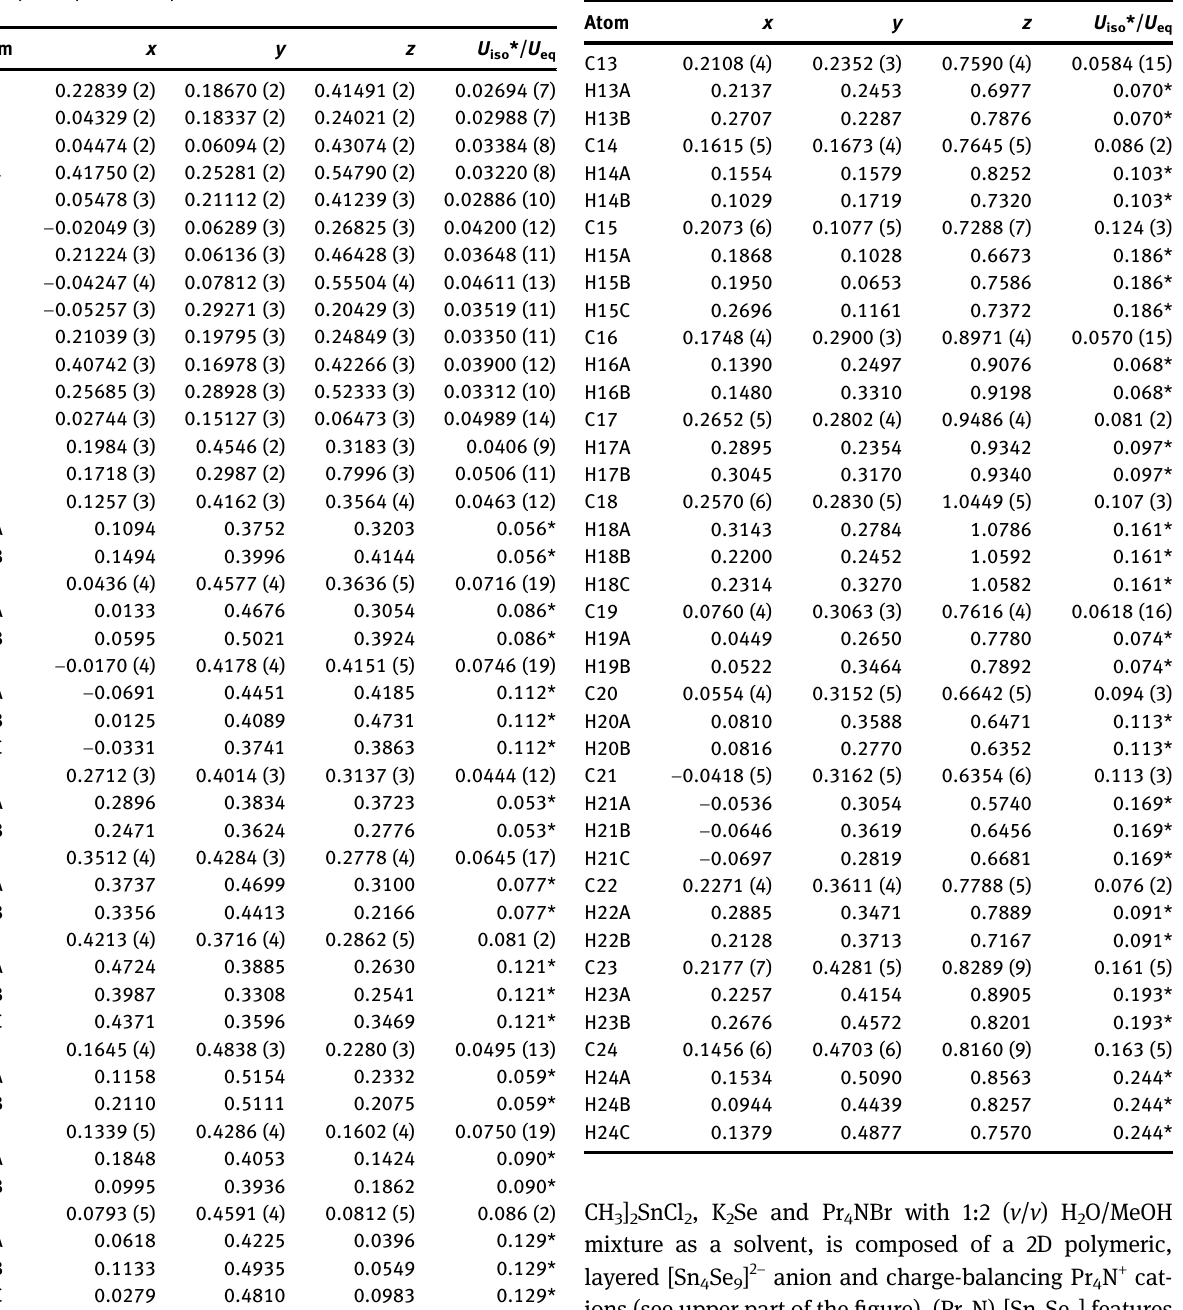
Table  : Fractional atomic coordinates and isotropic or equivalent isotropic displacement parameters (Å 